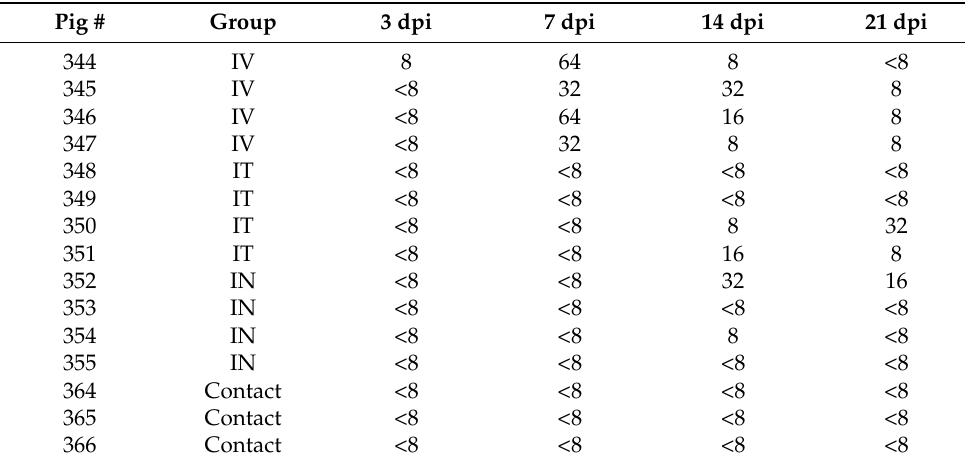
Table 2. Virus neutralization titers of virus challenged pigs and